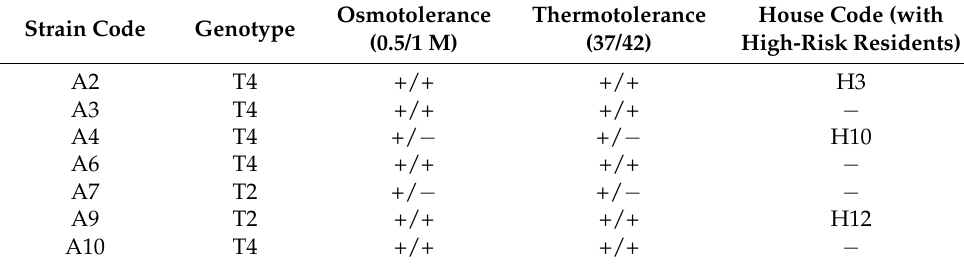
Table 4. Data regarding the pathogenicity of Acanthamoeba spp. using a tolerance test. Strain